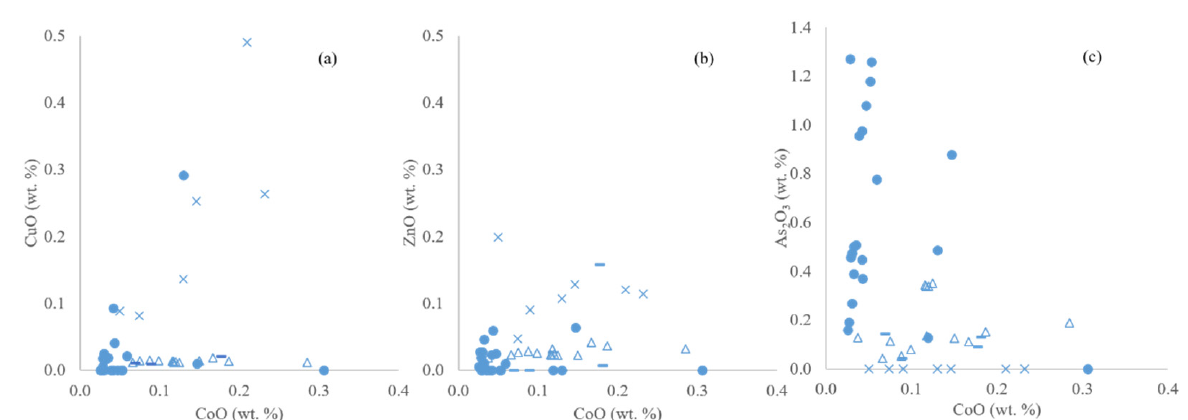
Figure 4. Oxides associated with the colour of blue glass; CoO, CuO as colouring agents and ZnO, As 2 O 3 as examples of accompanying oxides. ( a ) CuO plotted against CoO for blue glass from different historical periods; higher CuO contents are clearly visible in medieval glass samples and less frequent in later glasses (18th–19th century), ( b ) ZnO plotted against CoO, higher zinc contents again recorded in medieval glasses. Contents of CuO and ZnO are rather constant in early modern/Renaissance blue glass; CuO ≈ 0.01 wt % and ZnO ≈ 0.03 wt %, ( c ) plotting of As 2 O 3 against CoO; the presence of As 2 O 3 is confirmed in the glass from the 16th century or younger. The cobalt contents of the glass from the 18th–19th century are lower compared to the glass from earlier periods. According to higher values of As 2 O 3 , it is possible to deduce probable additions of arsenic to the glass batch. Symbols: × —medieval glass, ∆ —early modern/Renaissance glass, • —glass of 18th–19th century and—glass of 2nd half of 19th century. Details concerning the samples are provided in the supplementary file, Table S1.